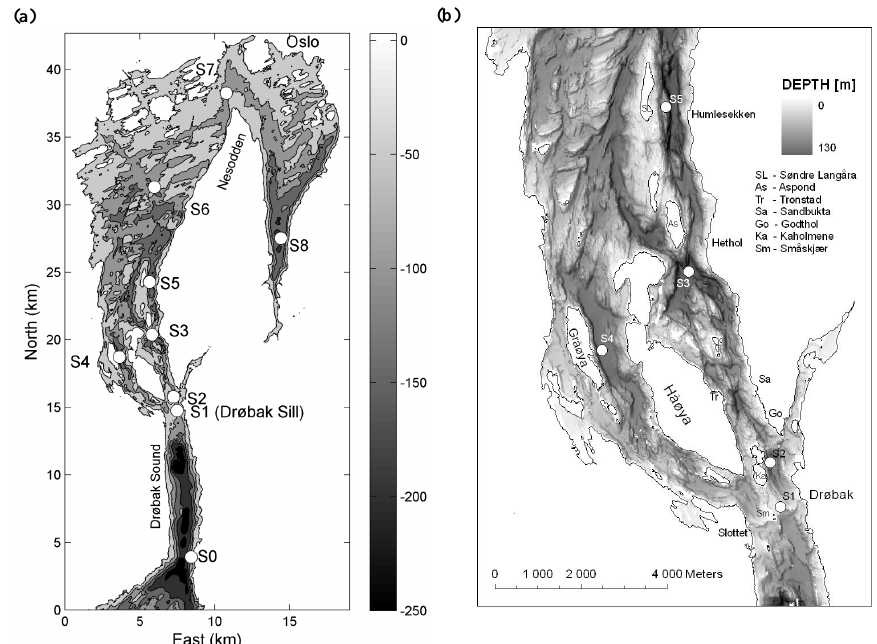
Fig. 1. (a) Map of the inner Oslofjord. Depth contours are drawn for every 50 meters. Moorings were deployed at station S0 (Brenntangen), S1 (Drøbak Sill), S2 (Kaholmen) and S5 (Søndre Lang˚ara). Stations S3, S4, S5, S6, S7 and S8 marked with white circles are standard hydrographic stations from the monitoring program. (b) Map of the area around the Drøbak Sill. Bathymetric data are from the Geological Survey of Norway (Lepland et al., 2009). A grey scale indicates the depths down to 130 meters. A hillside shade effect is used to emphasize the bathymetric structure. Stations are marked with grey circles. The subsurface Drøbak Jetty runs from Kaholmen to Sm˚askjær and further to Slottet on the west side of the sound. The Drøbak Sill (19.5m) is located between Sm˚askjær and Drøbak. There is a sill between Kaholmen and Godthol (47m) and another one between Tronstad and Sandbukta